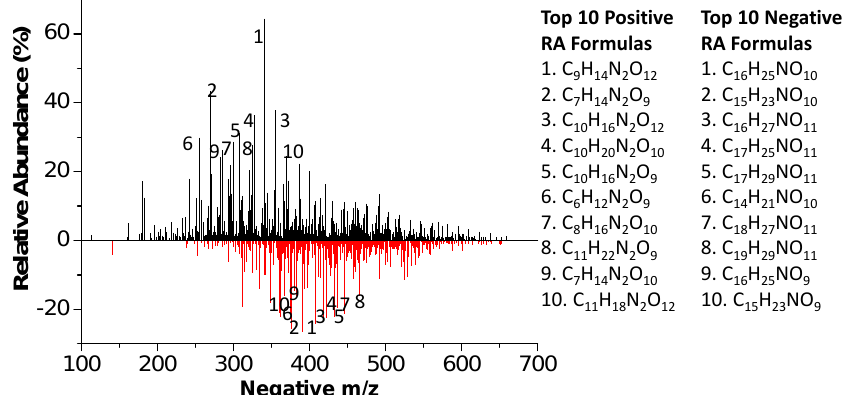
Fig. 8. Difference mass spectra of CHNO compounds between CW1 and CW2. Positive relative abundance (black peaks) means the com- pound has higher relative abundance in CW1; negative relative abundance (red peaks) means the compound has higher relative abundance in CW2. The molecular formulas with top 10 positive and top 10 negative relative abundances are also shown in the